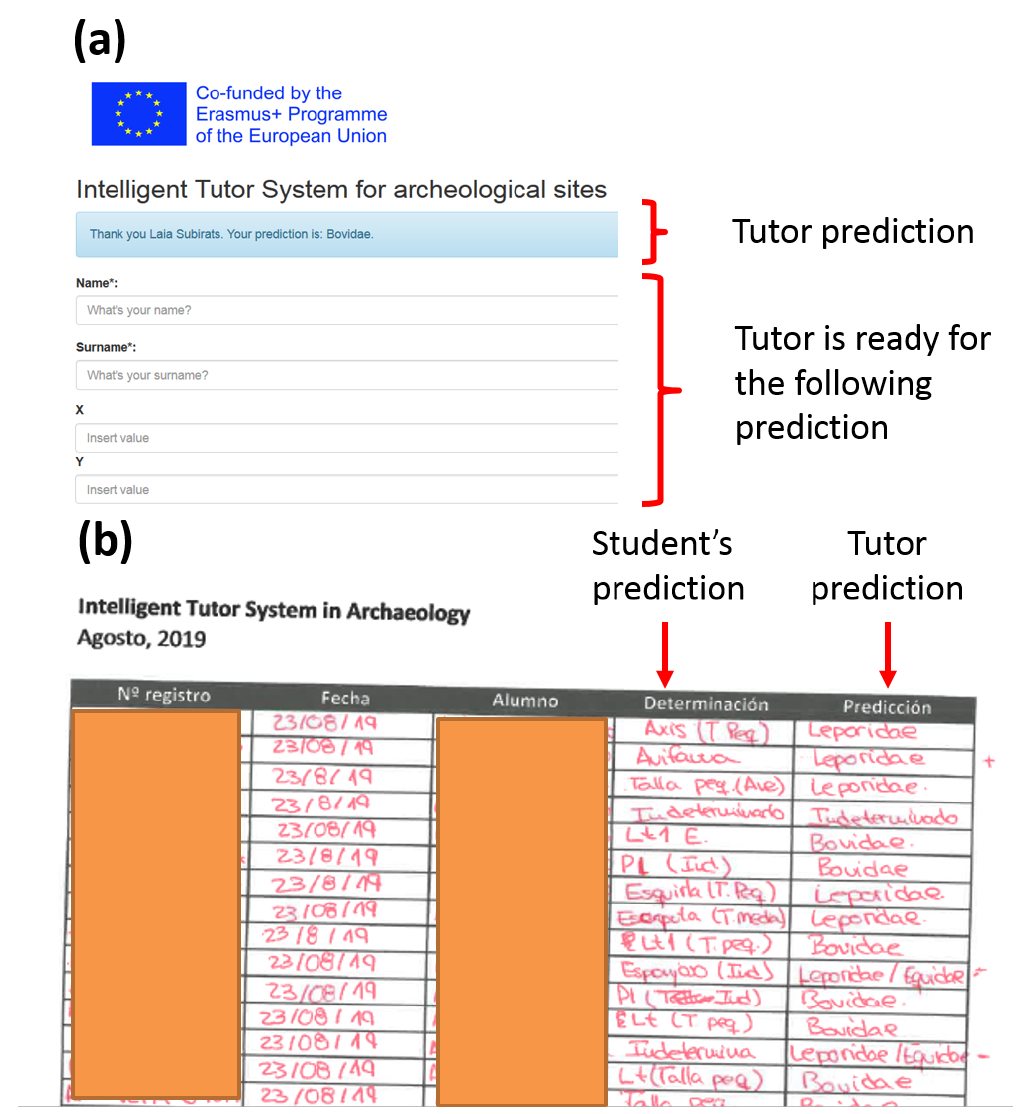
Figure 8. Tutor prediction ( a ) and student’s/tutor prediction table ( b